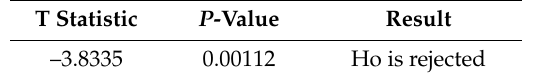
Table 11. T-test results of group 1 (FPBST) and group 2 (DT+) accuracies obtained from Table